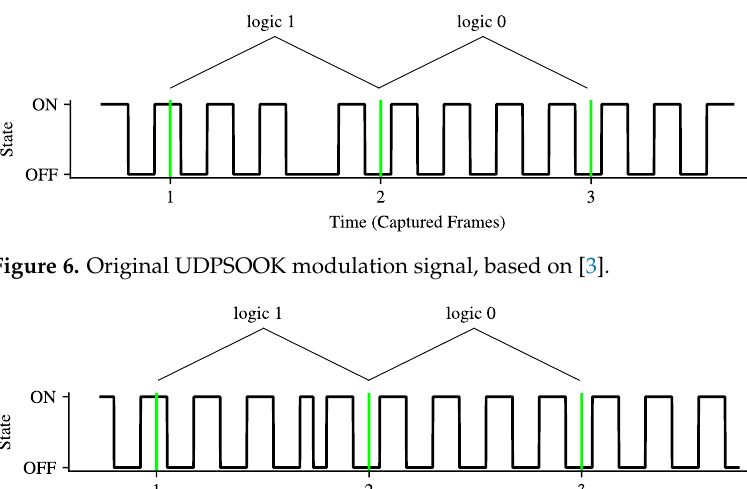
Figure 5. Car with modulated taillights at various distances from close-up to farther away [1].